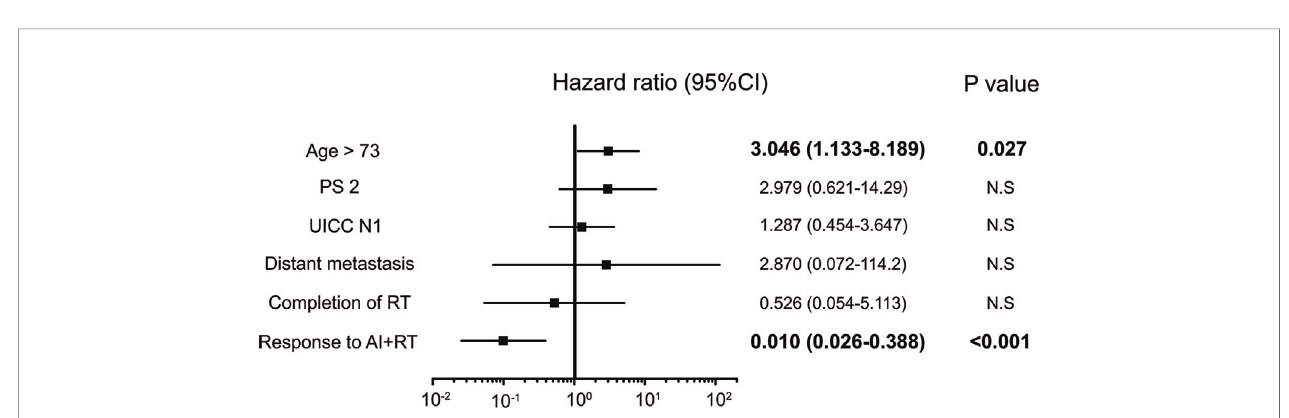
FIGURE 5 | Signi fi cant independent prognostic factors of bile duct cancer (BDC). The response to AI+RT and age ≥ 73 years old were signi fi cant prognostic factors in the multivariate analysis. A response to AI+RT had the lowest HR at